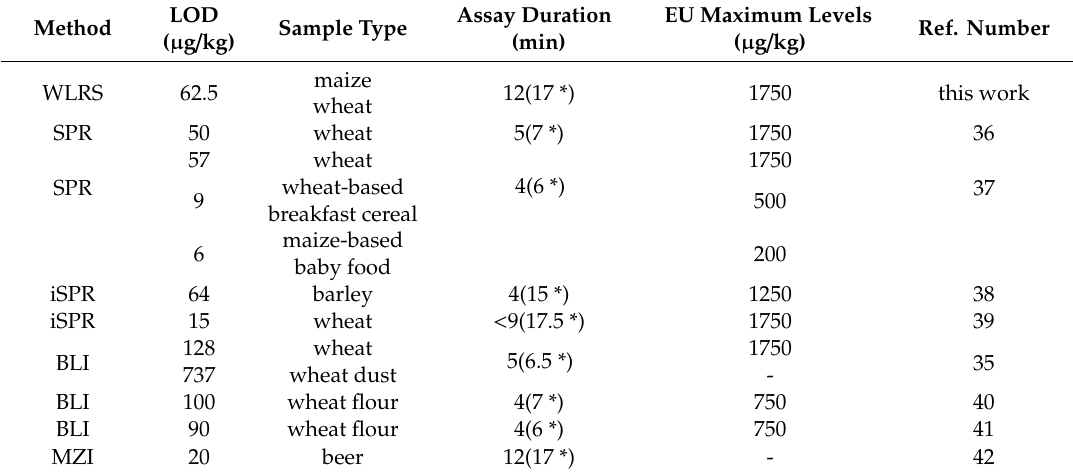
Table 2. Comparison of the White Light Reflectance Spectroscopy (WLRS) DON assay with other optical sensors reported in the